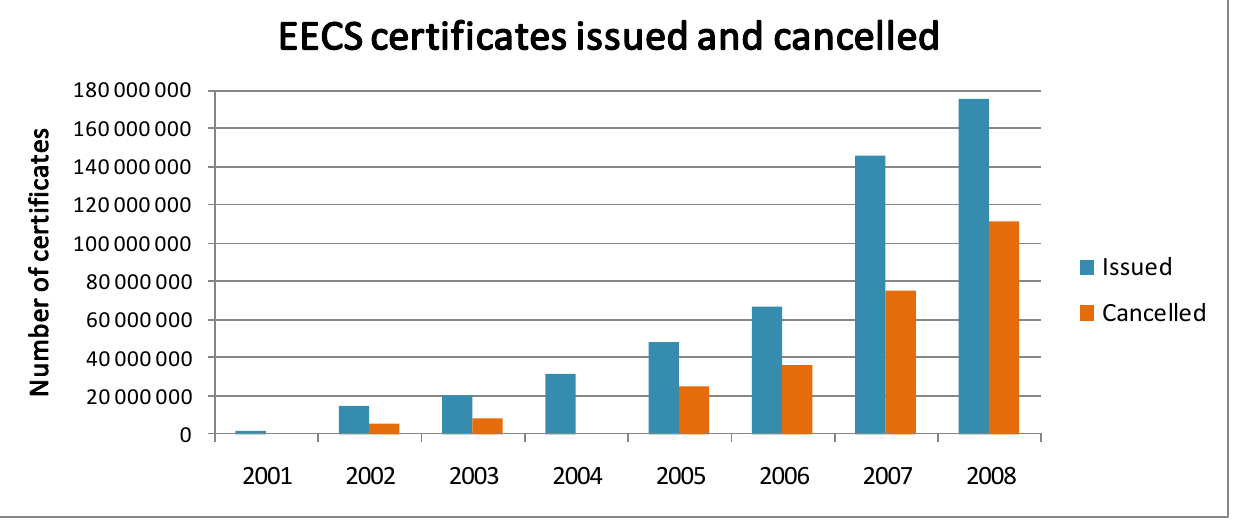
Figure 1. The number of issued and cancelled EECS certificates per year from 2001 to 2008 (1 certificate equals 1 MWh)